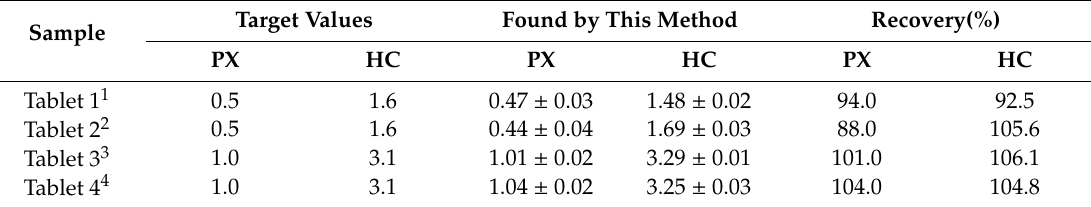
Table 3. Pyridoxine(PX) and hydrochlorothiazide(HC) in commercial tablets as determined by the Table 2. Prediction results for pyridoxine(PX) and hydrochlorothiazide(HC) validation samples by proposed method (mg / different chemometrics methods ( μ g/mL).